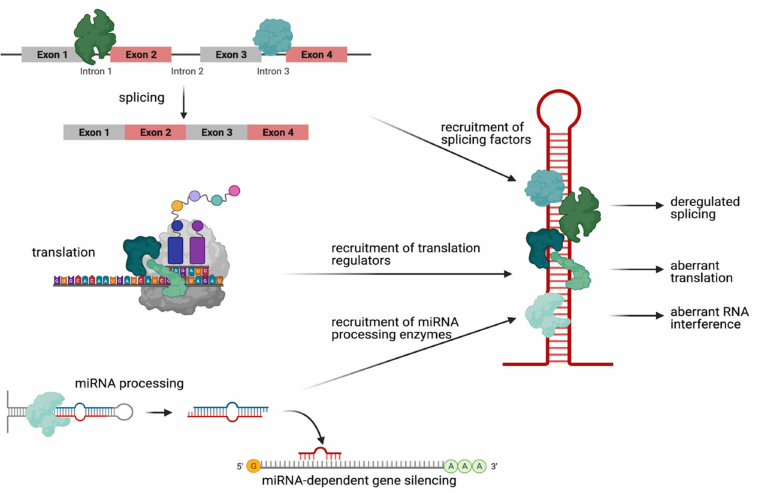
Figure 1. Schematic showing pathogenic mechanisms driven by mutant HTT RNA hairpin structures. More than 40 proteins bind to HTT RNA in a CAG repeat length-dependent manner. Most of them play a role for RNA splicing (upper panel). This recruitment of splicing factors leads to deregulated splicing of the mutant HTT transcript itself as well as to mis-splicing of other mRNA transcripts (upper panel). Some other proteins are instead translation regulators. These, when aberrantly bound to mutant CAG repeat RNA, recruit the translation initiation machinery and thus induce protein synthesis of neurotoxic polyglutamine proteins (middle panel). Finally, few proteins are RNA-processing enzymes of the RNAi machinery. These, when bound to mutant HTT RNA, cleave small CAG repeat RNAs (sCAGs) that finally cause silencing of CTG-containing RNAs (lower panel). Created with BioRender.com (accessed on 23 February